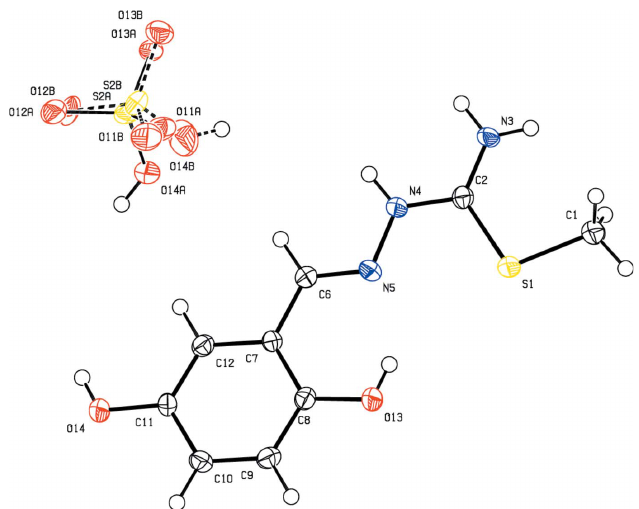
Figure 1 The molecular structure of the title molecular salt, showing the labelling and with displacement ellipsoids drawn at the 50% probability level. The disordered hydrogen sulfate anion is shown.